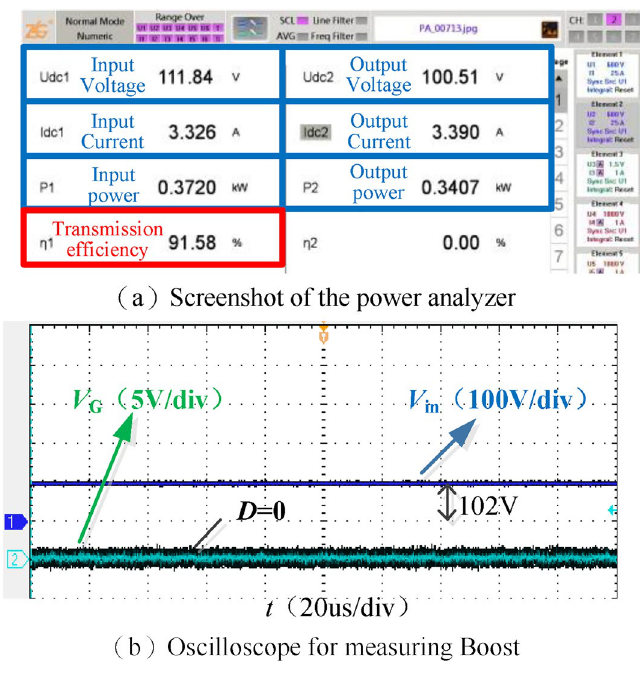
Figure 17. Main data and waveforms without compound control when R L = 29.6 Ω.